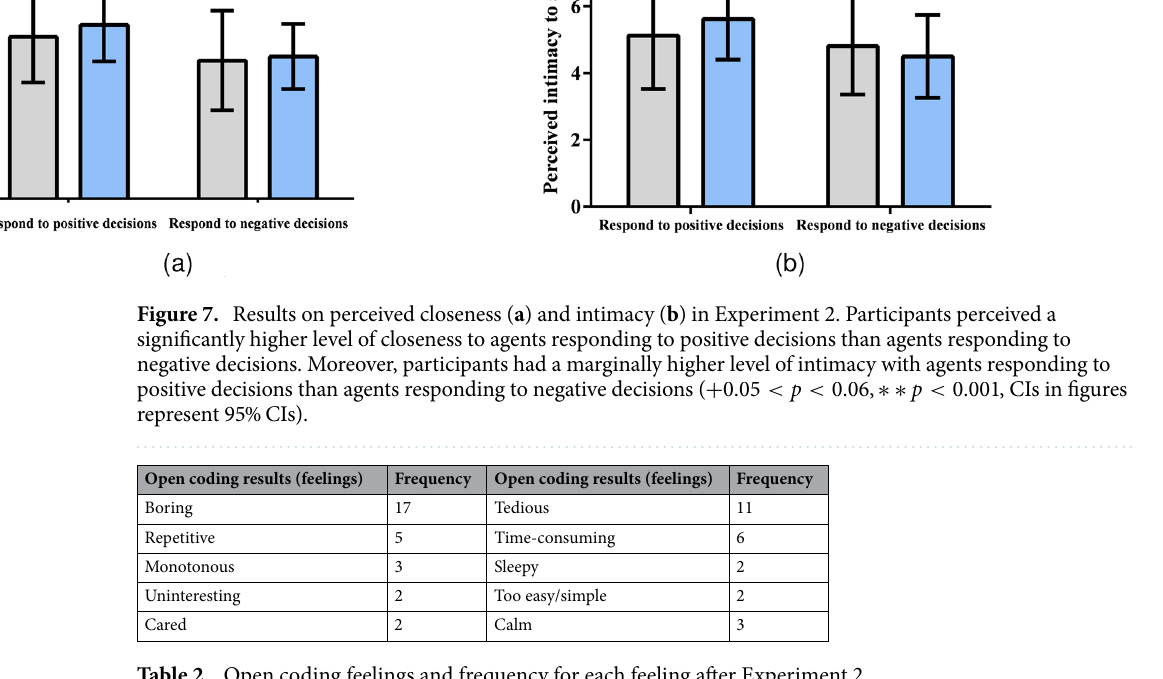
Table 2. Open coding feelings and frequency for each feeling after Experiment